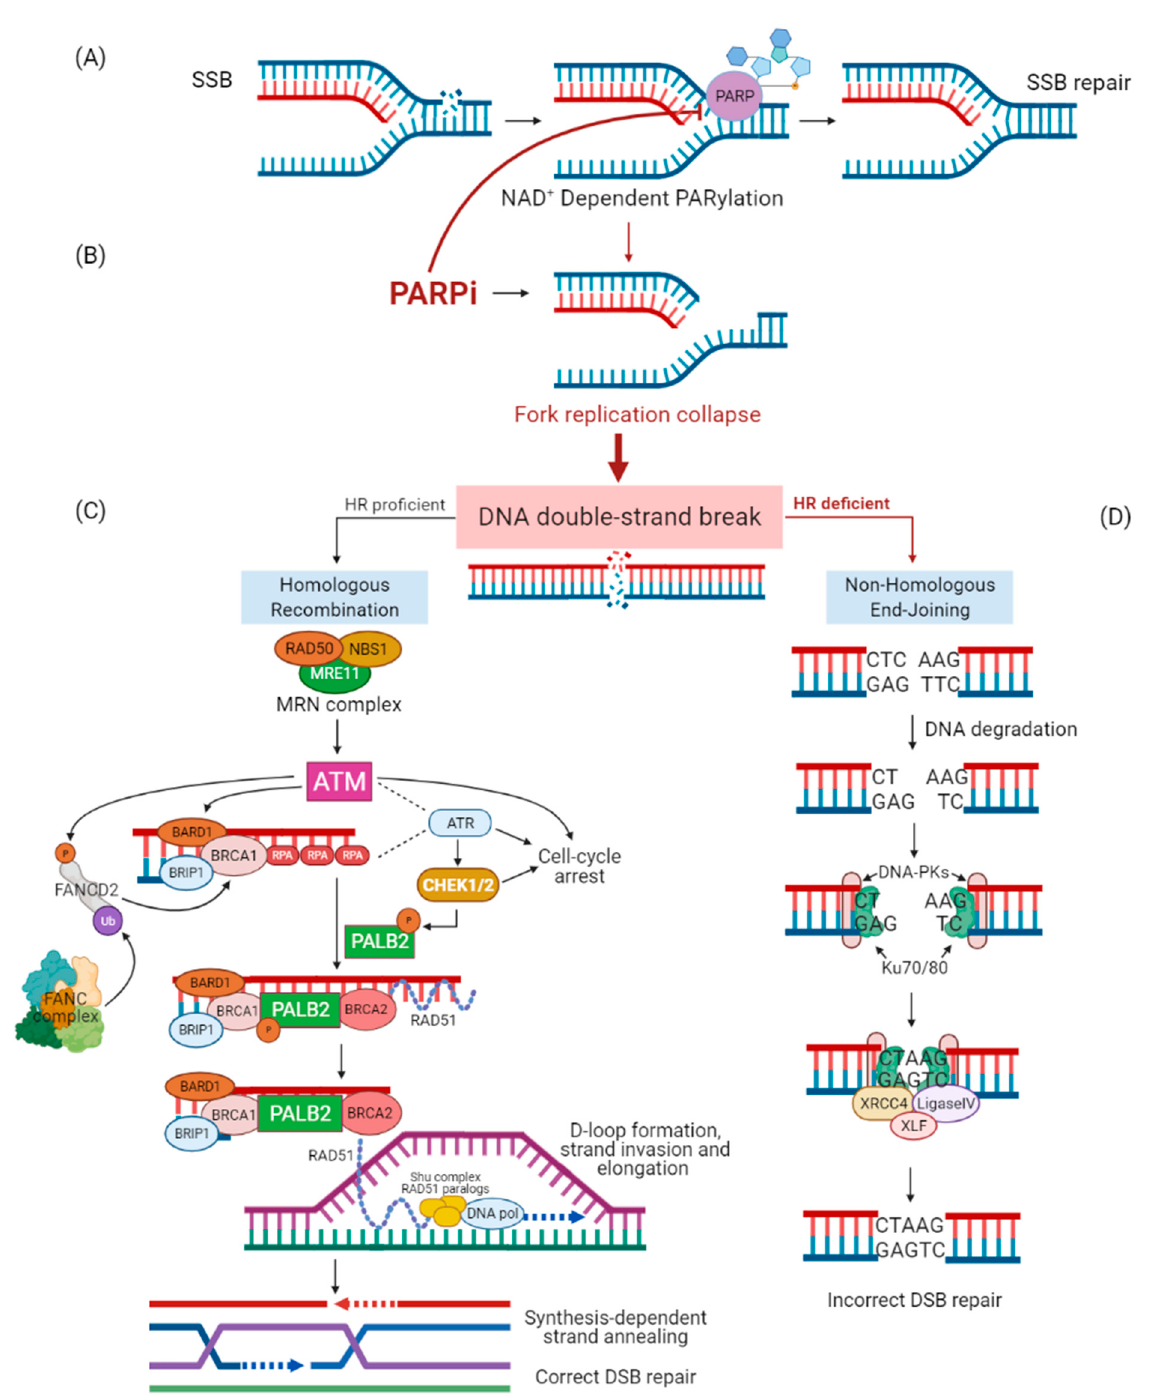
Figure 1. Overview of DNA double-strand break repair mechanisms and PARP inhibitor function. When DNA single- strand break (SSB) occurs, poly (ADP-ribose) polymerase (PARP) recruitment and activation leads to SSB repair through NAD+poly(ADP-ribosyl)ation (PARylation) of histones and chromatin remodeling enzymes and recruitment of PARP- dependent DNA-repair proteins ( A ). In the presence of PARP inhibitor (PARPi), PARP recruited to DNA SSB is no longer able to activate PARP-dependent repair systems and to dissociate from DNA-determining fork replication collapse during DNA replication ( B ). The collapsed replication fork creates a DNA double-strand break (DSB) that, in homologous recombination (HR)-proficient cells, is mainly repaired by the error-free mechanism of HR. MRN complex (Mre11, Rad50, and Nbs1) initiates DNA end resection, leading to the formation of single-strand DNA (ssDNA) at the extremity of the DSB; ssDNA is protected from degradation by the loading of replication protein A (RPA). The MRN complex recruits and acti- vates ataxia telangiectasia mutated (ATM); ATM and RPA contribute to ataxia telangiectasia and Rad3-related (ATR) ac- tivation. Once activated, ATM and ATR phosphorylate several proteins involved in the HR pathway, such as checkpoint